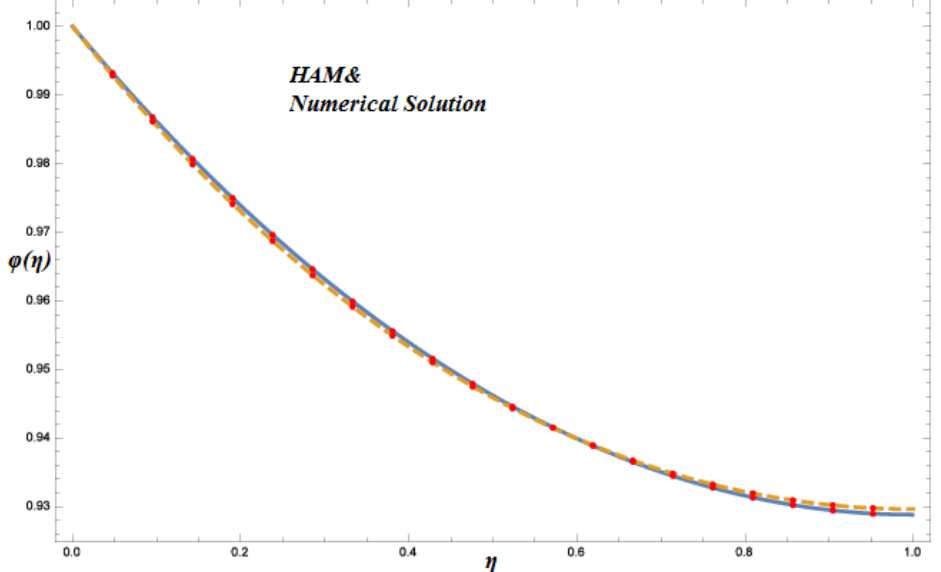
Figure 6. The comparison between HAM and numerical solutions for concentration fields ϕ ( η ) , when (cid:125) = − 0.25, P r = 10, B r = 0.1, N r = 0.1, D u = 0.1, S c = 0.1, ε = 0.1, S r = 0.1, λ = 0.1, Λ = 0.1, β = 1, S = 0.1.